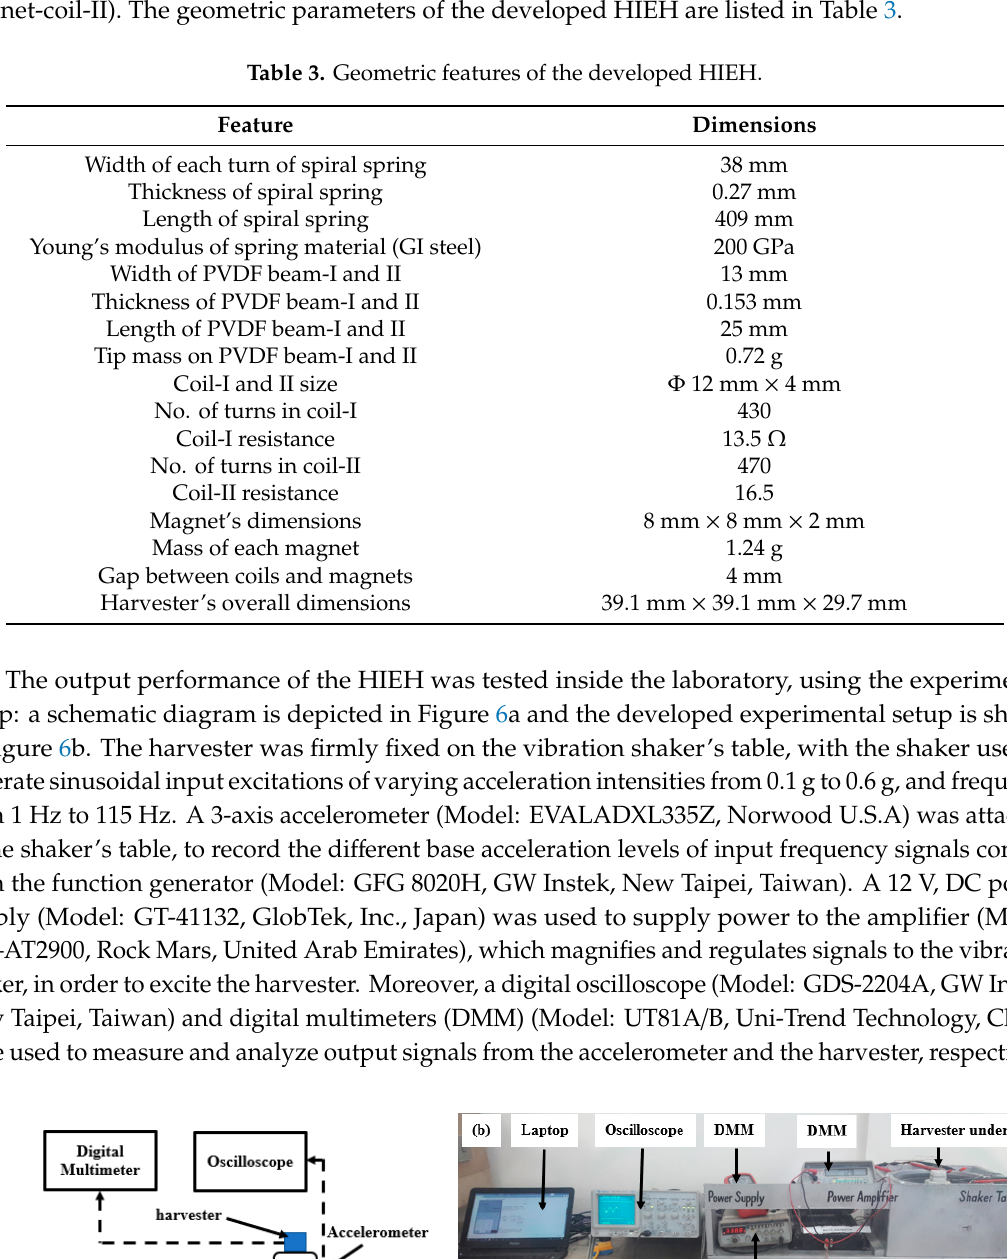
Table 3. Geometric features of the developed HIEH.